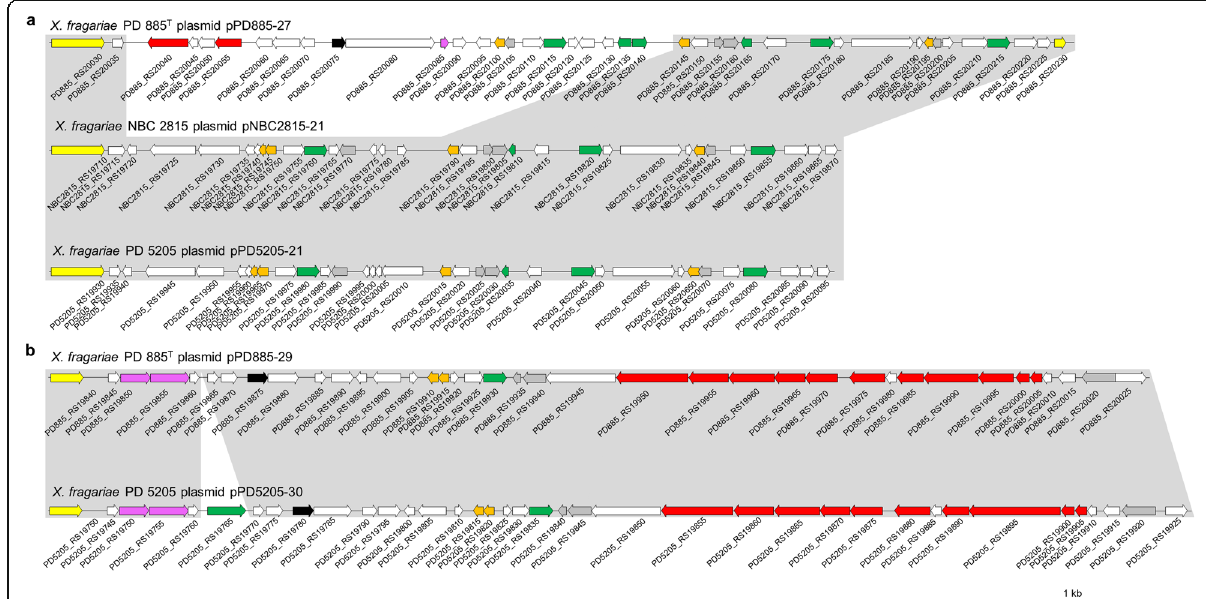
Fig. 4 The two plasmid families present in three complete Xanthomonas fragariae genome sequences. a The plasmid family pXf21 was variable between strains and an 8-kb region found in both pNBC2815 – 21 and pPD5205 – 21 is substituted by a 14-kb region in the plasmid pPD885 – 27, which includes two conjugal transfer proteins (VirB) and a mobilization protein, not present in the two other plasmids from pXf21 family. b The plasmid family pXf29 showed a greater conservation between the strains and only an additional transposase (PD5205_RS19760) was found in plasmid pPD5205 – 30. The genes are color-coded; yellow: replication proteins, orange: toxin-antitoxin related genes, green: recombinase, resolvase and transposase, red: type IV secretion systems (VirB cluster), black: relaxase protein MobC, pink: chromosome partitioning, white: hypothetical proteins, and grey: other genes. The grey shadings between the plasmids correspond to > 99% nucleotide